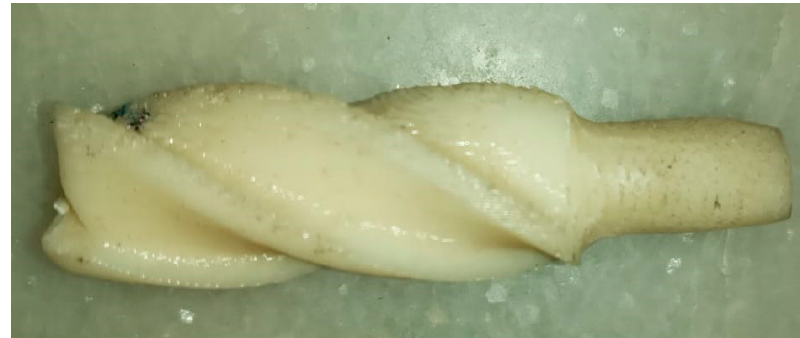
Figure 1. As-printed acrylonitrile-butadiene-styrene (ABS) end-mill tool.